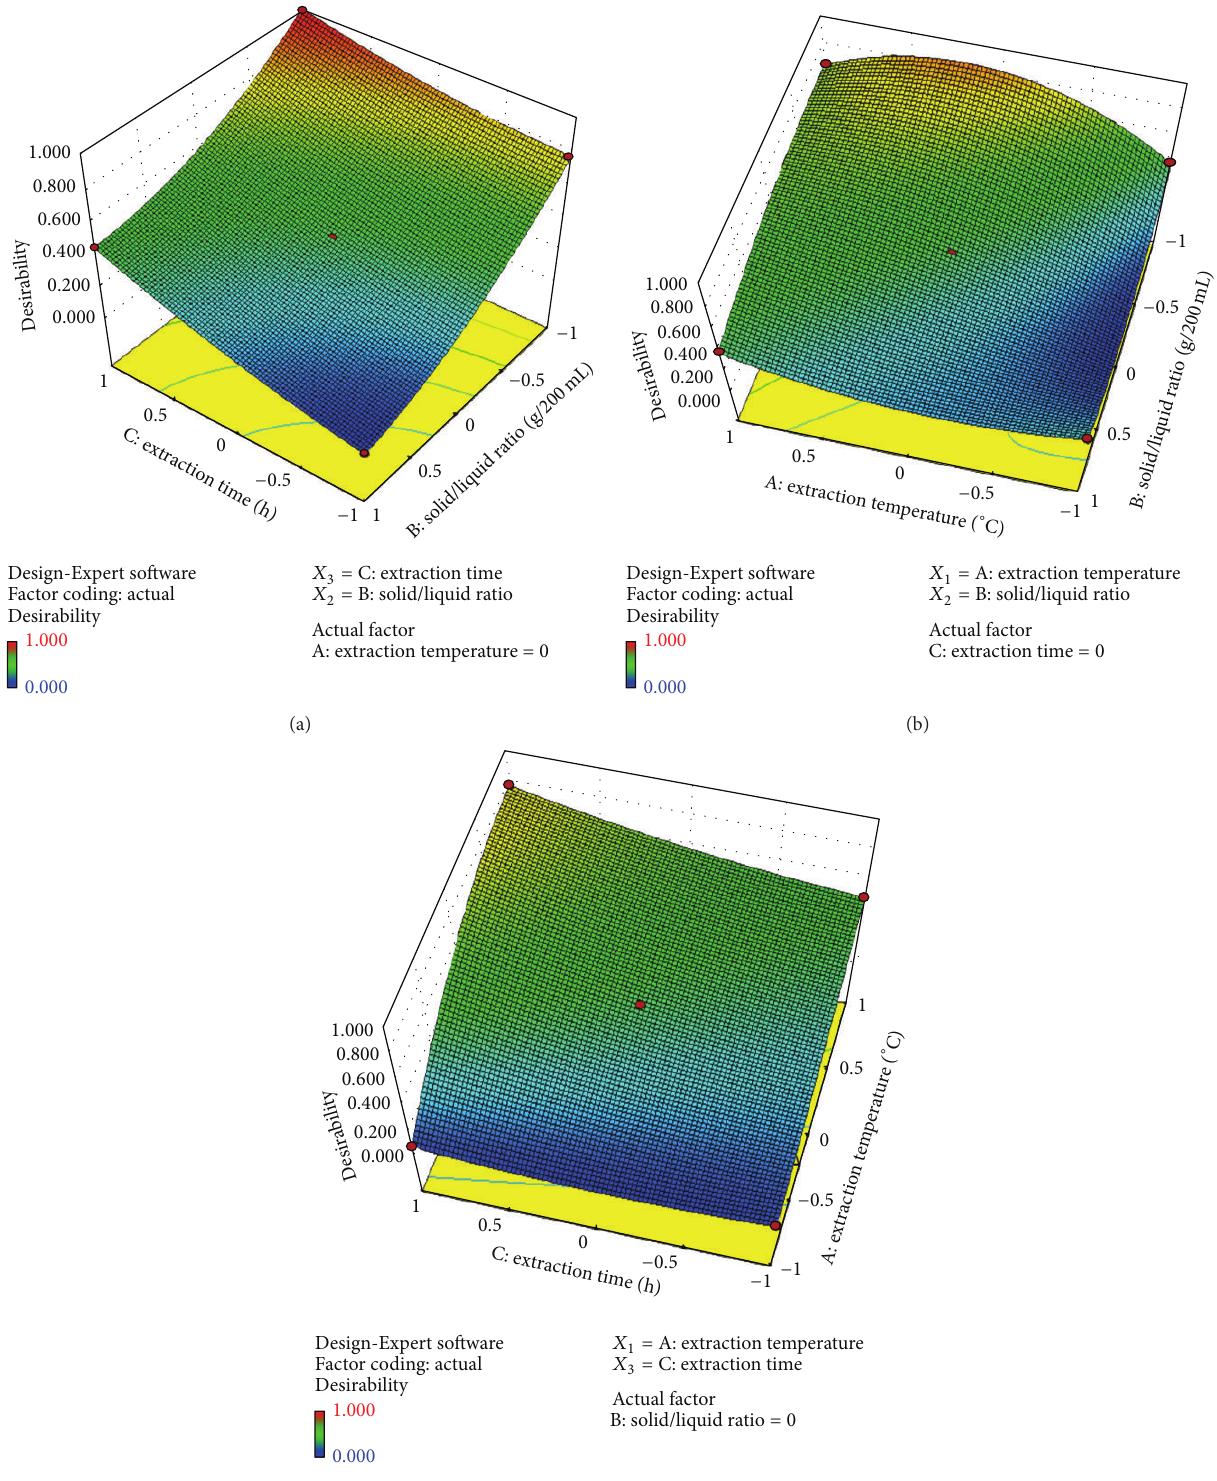
Figure 2: Three-dimensional response surfaces of the effective parameters on the extraction